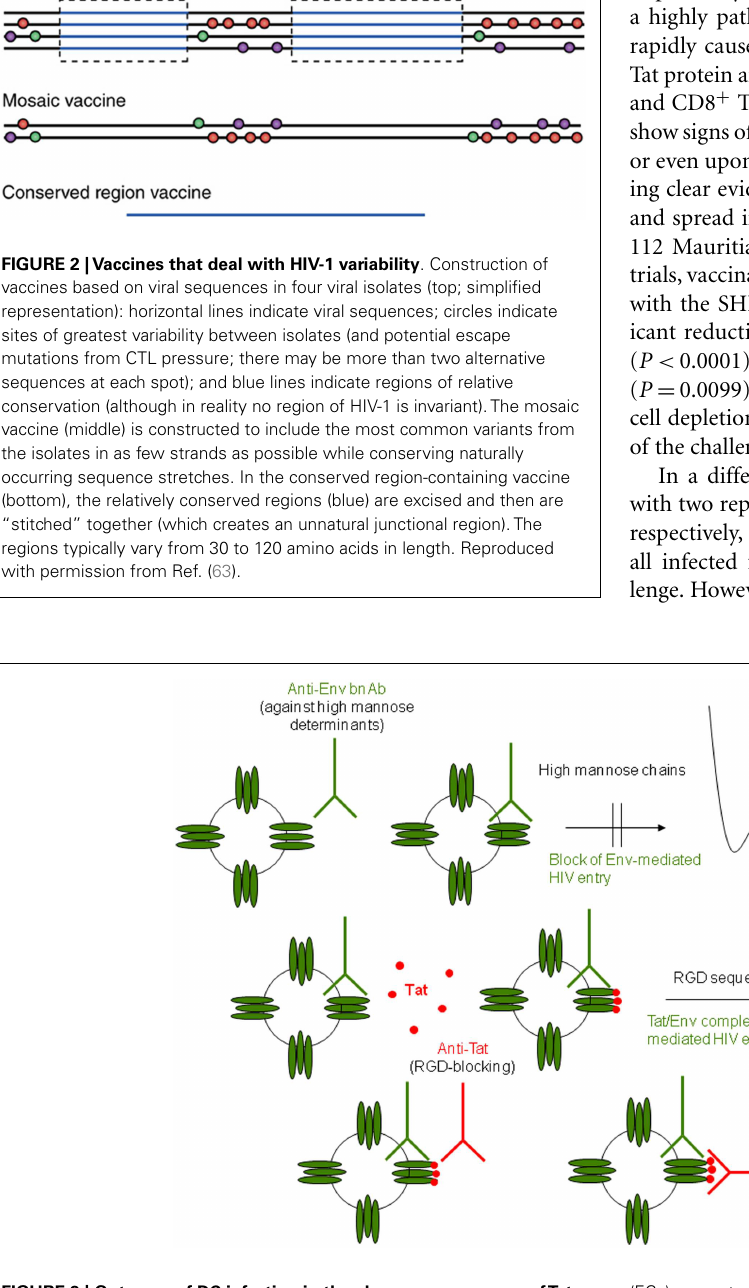
FIGURE 3 | Outcome of DC infection in the absence or presence ofTat, anti-Env, and/or anti-Tat antibodies .Tat redirects HIV to RGD-binding integrins evading neutralization by anti-Env Abs and both anti-Env and anti-Tat Abs are required to block infection. ExtracellularTat released by infected neighbor cells binds to trimeric Env on HIV, decreasing recognition of C-type lectin receptors and promoting engagement of RGD-binding integrins, which are expressed by inflammatory DCs, macrophages, and endothelial cells